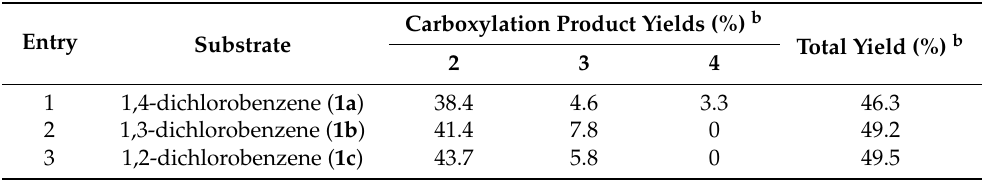
Figure 2. Cyclic voltammograms of 5 mM dichlorobenzene obtained on Ag electrode with the scan rate of 0.1 V/s in DMF + 0.1 M TEABF 4 ‐ : ( a ) 1,4 ‐ dichlorobenzene; ( b ) 1,3 ‐ dichlorobenzene; ( c ) 1,2 ‐ dichlorobenzene. Table 2. Electrocarboxylation of dichlorobenzenes a .